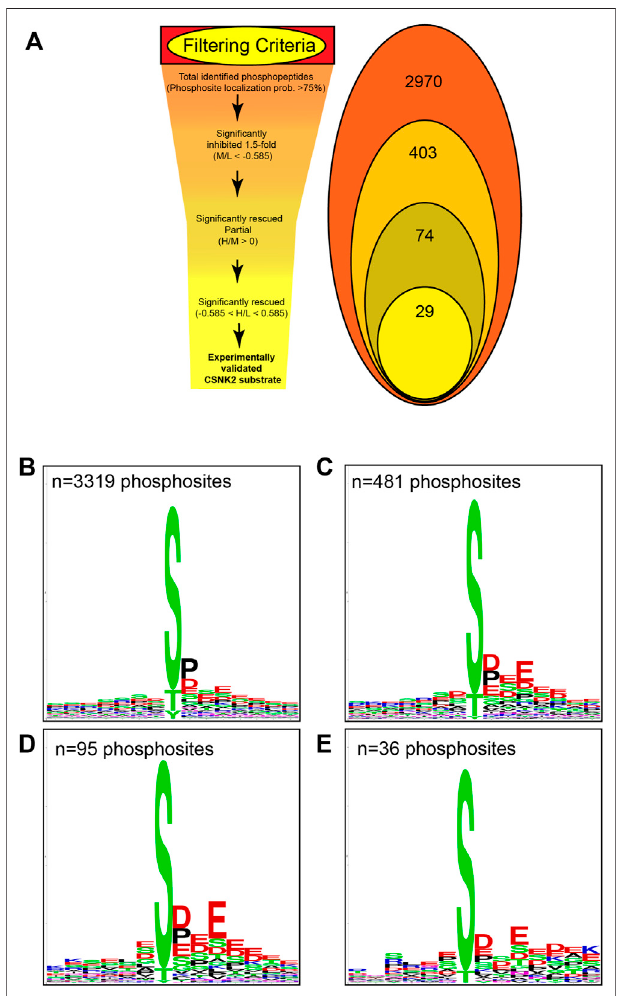
FIGURE 3 | Filtering criteria utilized in CSNK2 substrate identi fi cation and validation. (A) Filtering criteria utilized to identify CSNK2-dependent phosphopeptides. The number of distinct phosphopeptides that remained after each fi ltering step is displayed in the Venn diagram variation. WebLogo consensus sequence analysis was conducted on phosphosites identi fi ed (B) prior to fi ltering, (C) after fi ltering for phosphopeptides signi fi cantly inhibited, (D) after fi ltering for phosphopeptides demonstrating partial rescue, and (E) after fi ltering for phosphopeptides demonstrating rescue. The n values represent the number of phosphosites used for consensus sequence